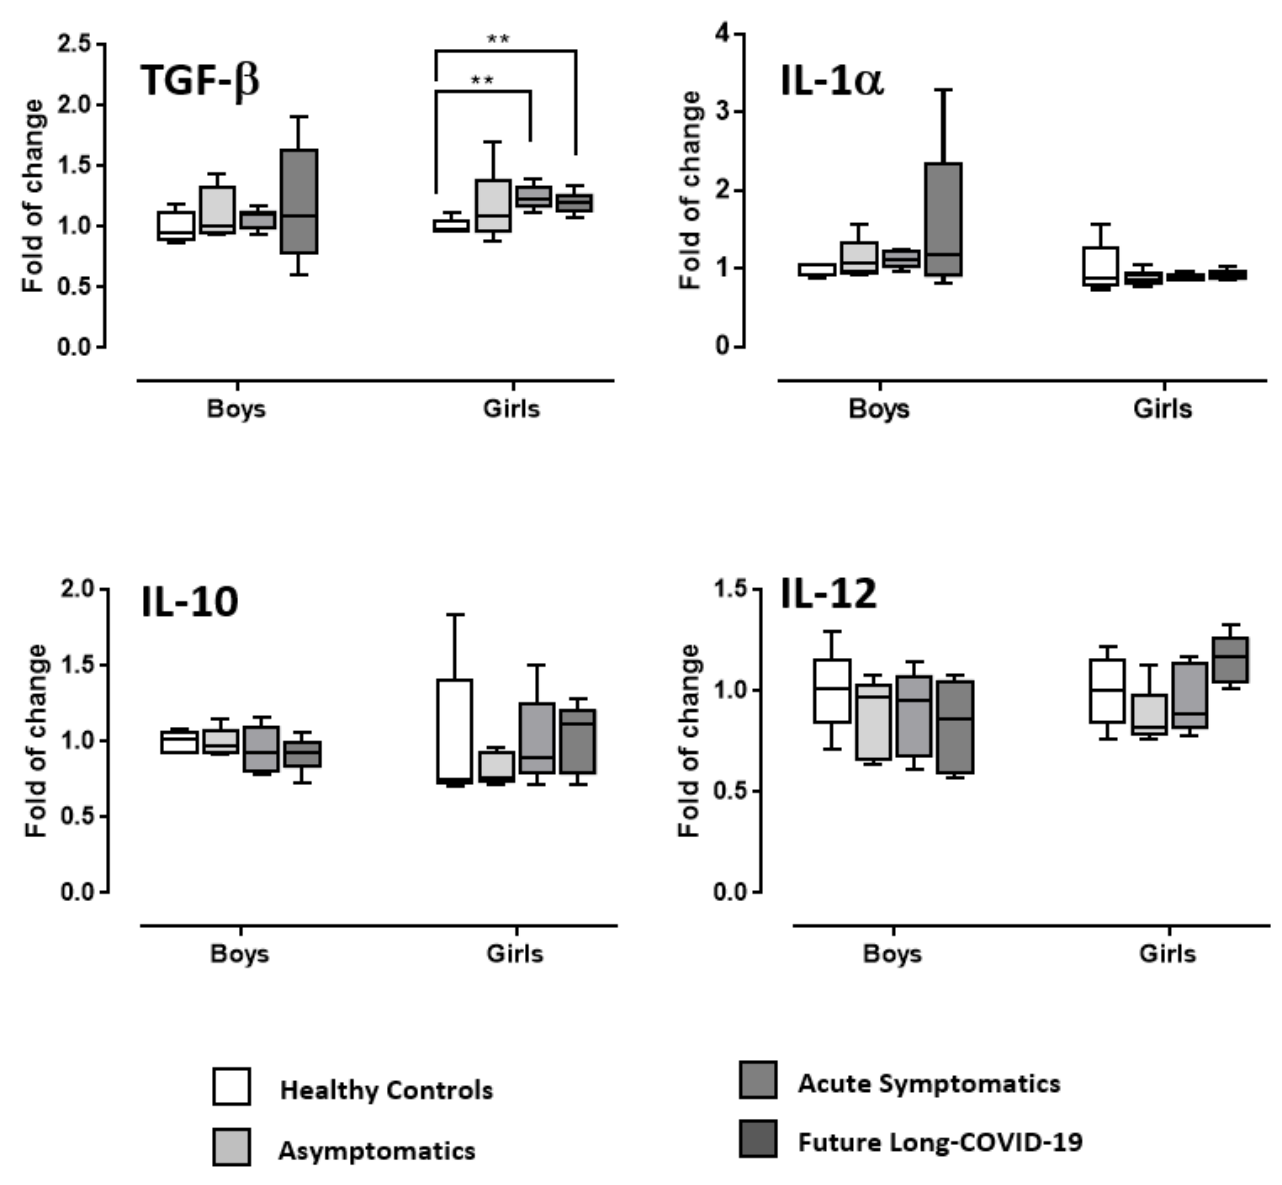
Figure 3. Serum TGF- β , IL-1 α , IL-10, and IL-12 in COVID-19 adolescents and healthy controls. According to their COVID-19 related outcomes, the recruited individuals were divided into three groups: asymptomatics, acute symptomatics, and symptomatics that over time developed long- COVID-19 symptoms (“future long-COVID-19”); as a control group we analyzed the serum of age-matched healthy controls that did not contract the infection. Boxes indicate the lower and upper quartiles. The vertical lines extending from each box represent the minimum and maximum values. The asterisks indicate significant differences between groups (** p < 0.01).